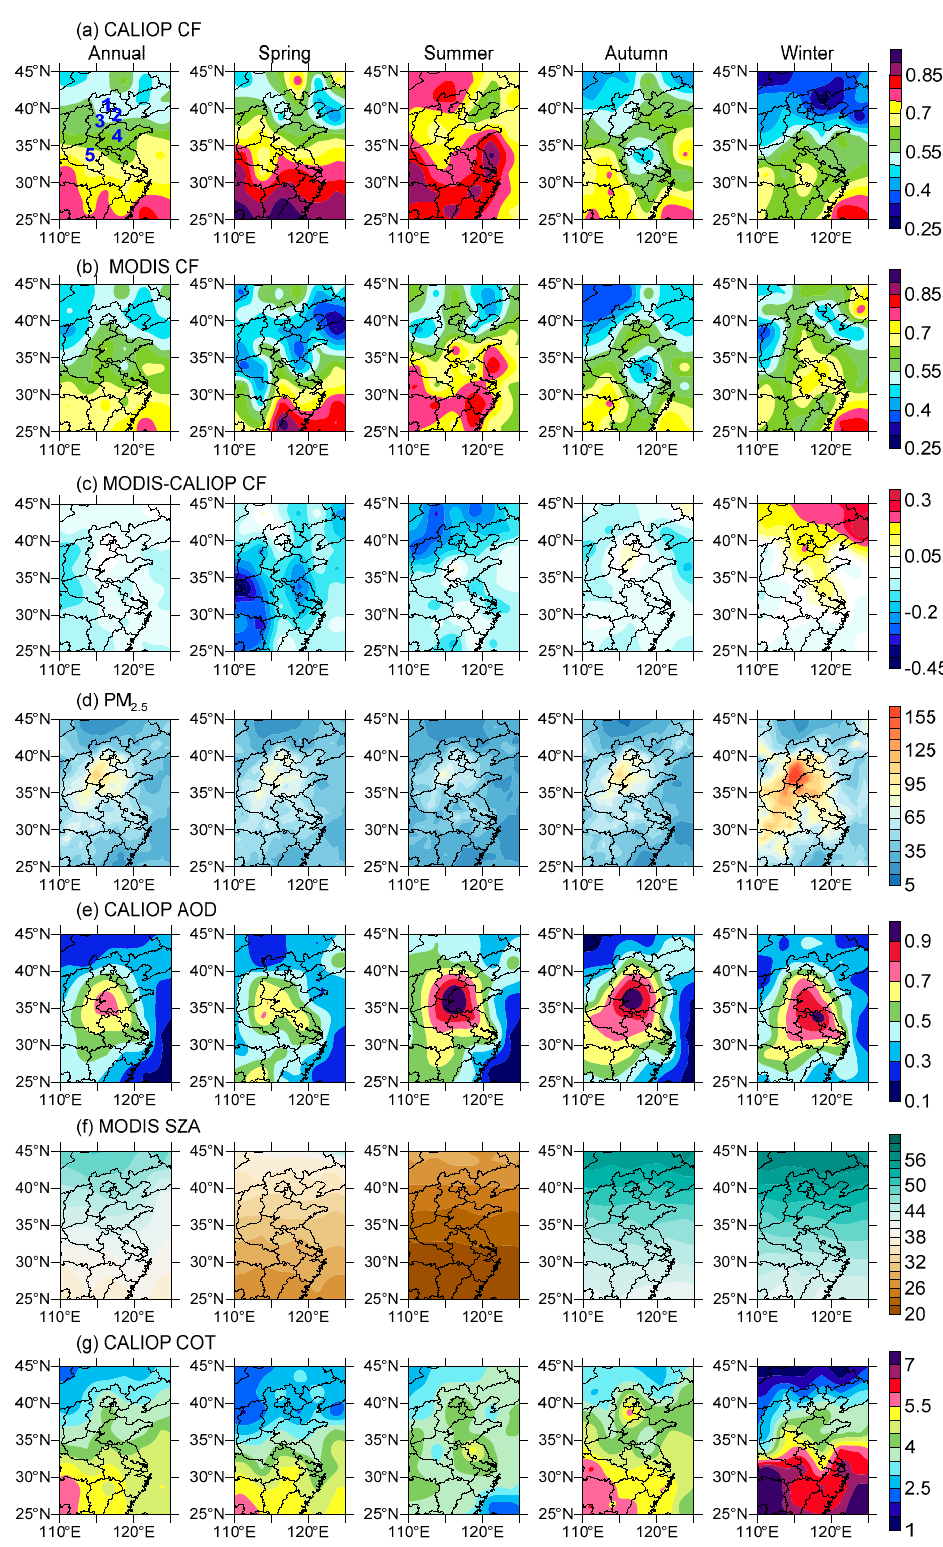
Figure 9. Annual and seasonal averages of ( a ) CALIOP cloud fraction (CF); ( b ) MODIS CF; ( c ) the CF di ff erence between MODIS and CALIOP; ( d ) PM 2.5 ( µ g m − 3 ); ( e ) AOD; ( f ) SZA; and ( g ) COT. Each row shows di ff erent parameters, and each column shows di ff erent seasons. Locations 1–5 in ( a ) Annual show Beijing and Tianjin cities, and Hebei, Shandong, and Henan